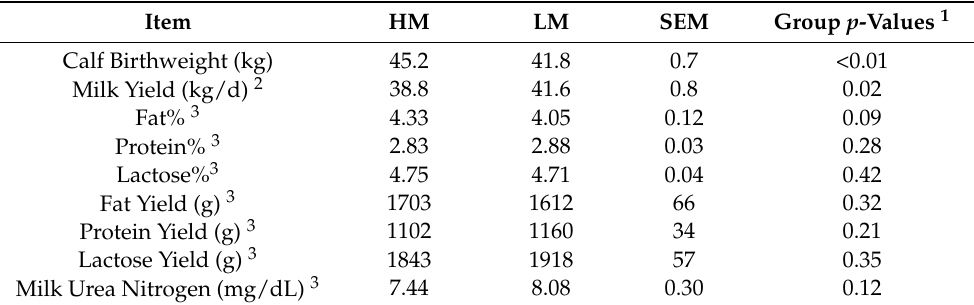
Table 5. Relation between high-muscle (HM; n = 20) and low-muscle (LM; n = 21) longissimus dorsi thickness (LDT) at 35 d before expected calving (BEC) on calf birthweight, milk production, and milk components through 60 days in milk